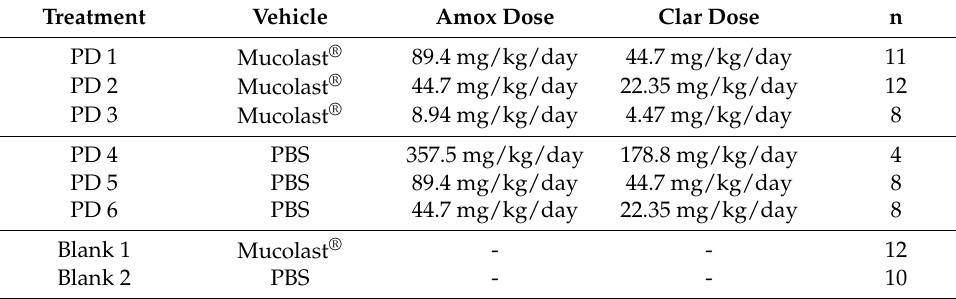
Table 2. Efficacy of groups per formulation, time, and